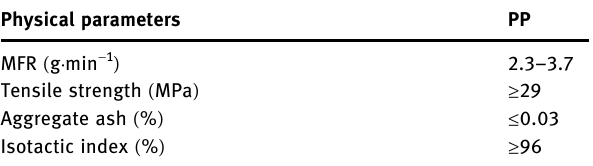
Table 1: Physical parameters of pure PP Physical parameters